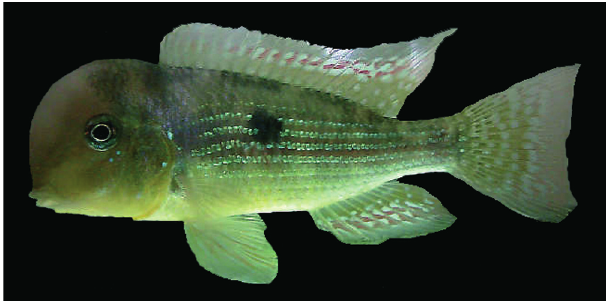
Fig. 2. Gymnogeophagus tiraparae , male not preserved from the río Yí, tributary to the río Negro (lower río Uruguay drain-